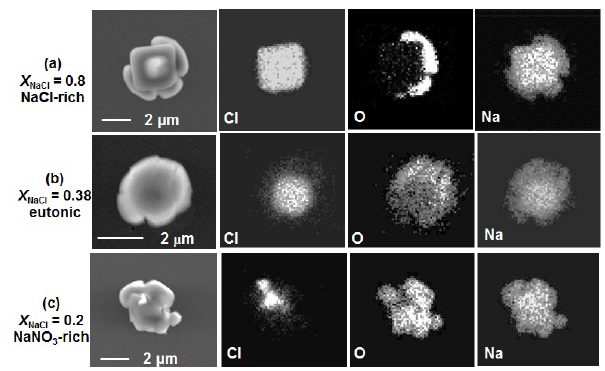
Figure 5. Secondary electron images (SEIs) and elemental X- Ray maps for Cl (from NaCl), O (from NaNO 3 ) , and Na of the effloresced NaCl–NaNO 3 mixture particles with compositions of (a) X NaCl = 0.8 (NaCl-rich); (b) X NaCl = 0 . 38 (eutonic); and (c) X NaCl = 0.2 (NaNO 3